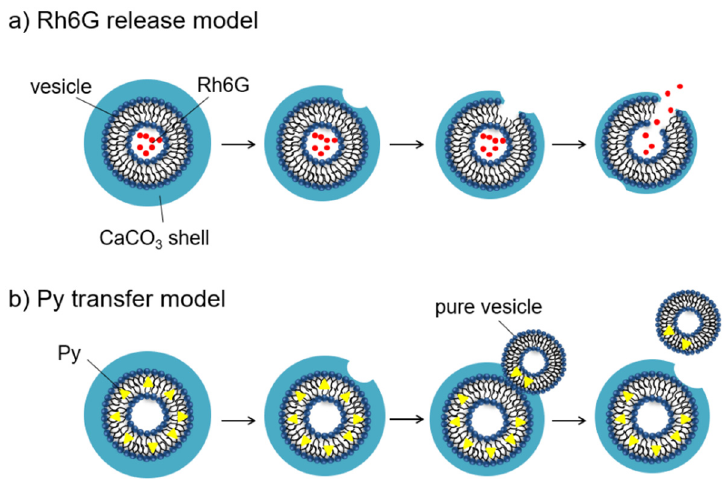
Figure 9. Schematic pictures of the drug release mechanism. ( a ) Release of hydrophilic Ph6G as a result of the collapse of the vesicle. ( b ) Transfer of hydrophobic Py as a result of contact with the vesicle.